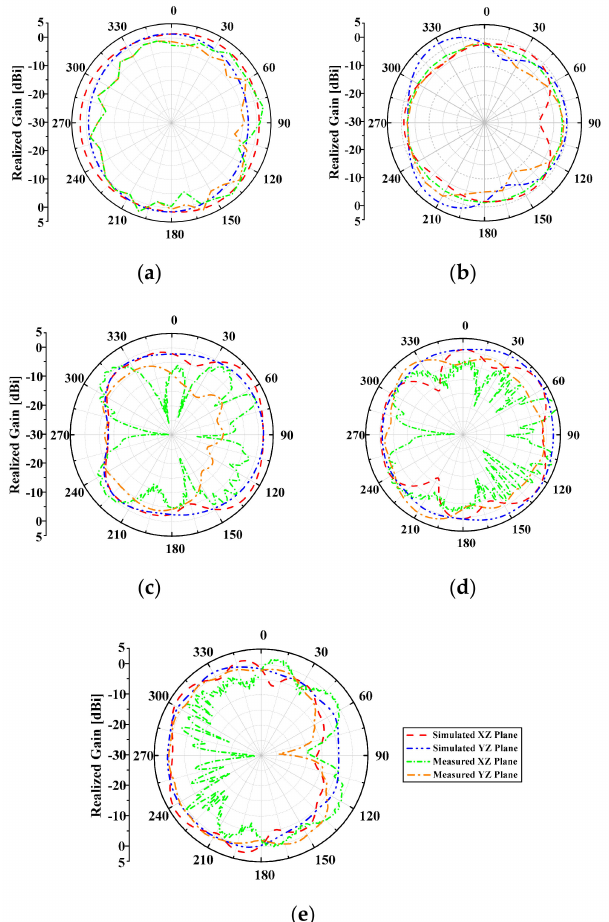
Figure 18. Simulated and measured radiation patterns of the NB antennas for various frequencies. ( a ) NB Antenna #1 at 3.5 GHz; ( b ) NB Antenna #1 at 4.9 GHz; ( c ) NB Antenna #2 at 6.52 GHz; ( d ) NB Antenna #2 at 7.65 GHz; ( e ) NB Antenna #3 at 9.5